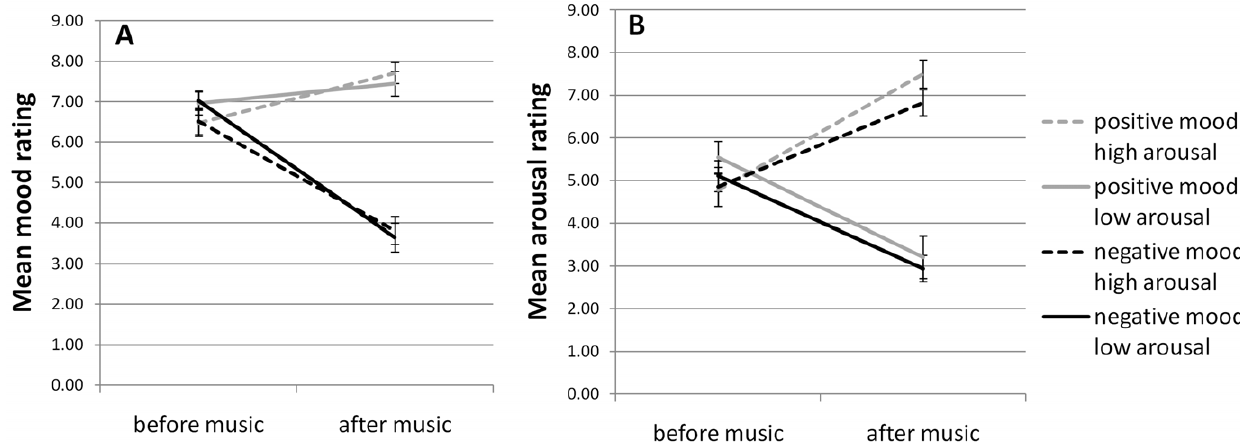
Figure 2. Subjective mood and arousal ratings before and after music presentation. (A) Mood ratings are seen to increase following presentation of music rated as more positive and decrease following music rated as negative. (B) Subjective arousal increased following music rated as highly arousing and decreased following music rated as less arousing. Error bars represent standard errors of the mean.